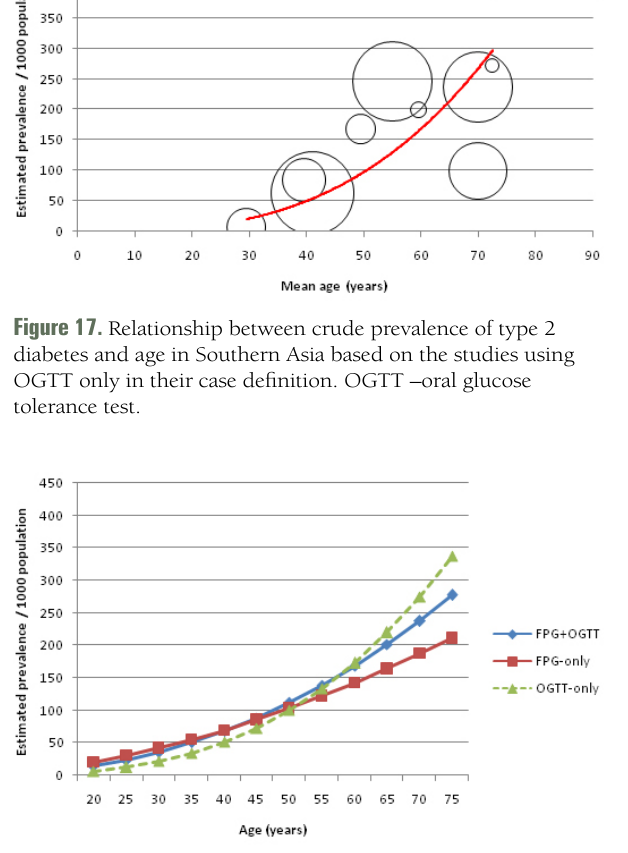
Figure 18. Comparison of the relationship between crude prevalence of type 2 diabetes and age in Southern Asia depending on the diagnostic methods used to establish case